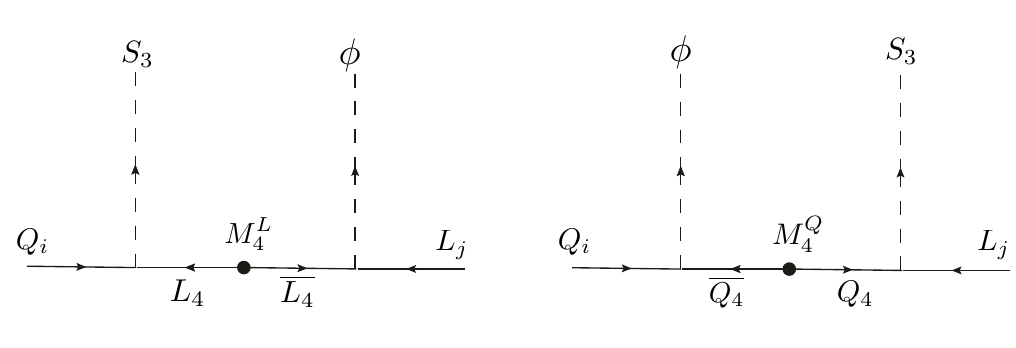
Figure 2 . Diagram in the model which leads to the e(cid:11)ective S